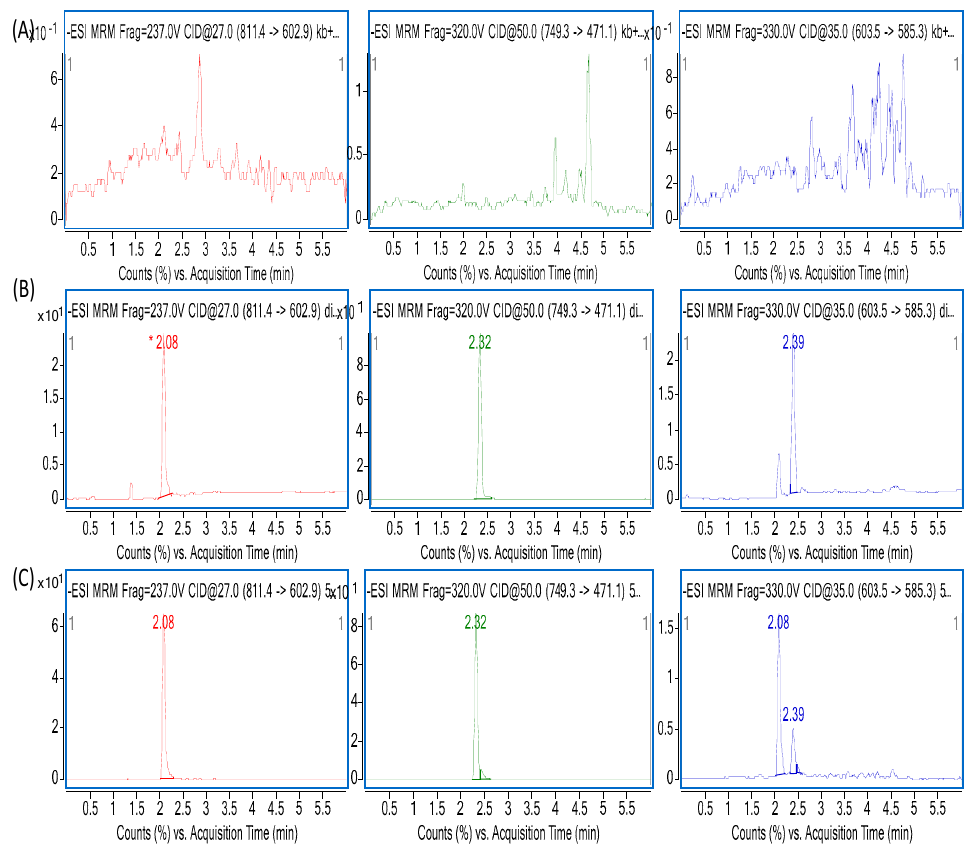
Figure 3. Representative MRM chromatograms of ZGS1, α -hederin (internal standard [IS]) and ZGS2 in ( A ) blank plasma sample; ( B ) blank plasma sample spiked with LLQC of ZGS1 (10 ng/mL) and ZGS2 (10 ng/mL), and IS (800 ng/mL); ( C ) rat plasma sample obtained 1h after subcutaneous injection of ZGS1 (10 mg/kg).